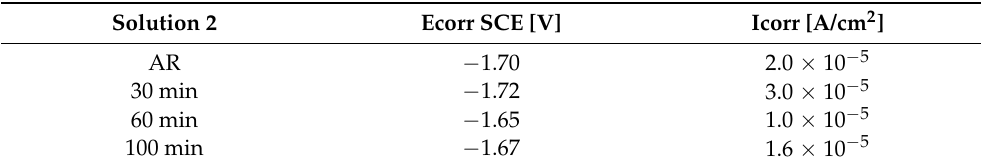
Table 5. Corrosion potential and corrosion current densities extrapolated from the potentiodynamic polarization plots reported in Figure 11b for the samples obtained with solution 2 at ambient